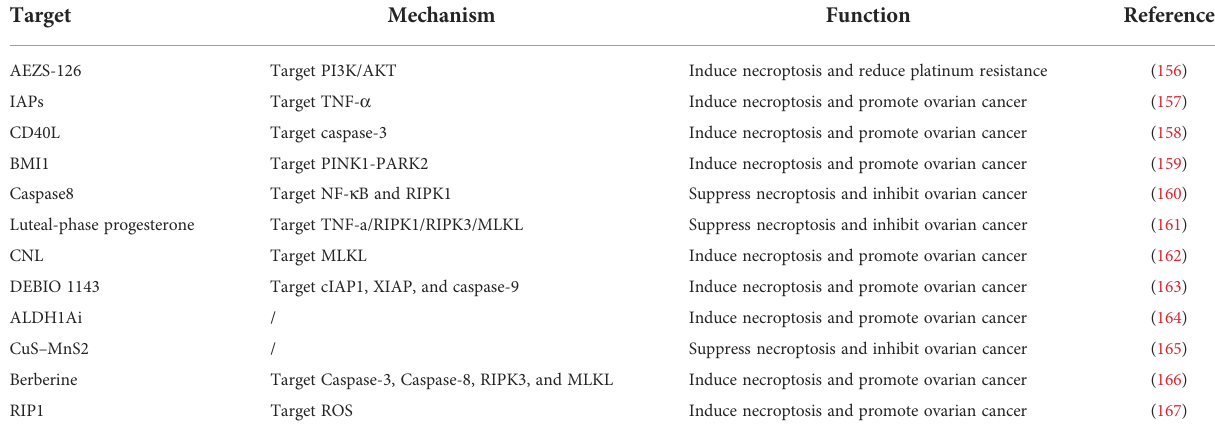
TABLE 3 The regulatory role of necroptosis related genes in ovarian cancer